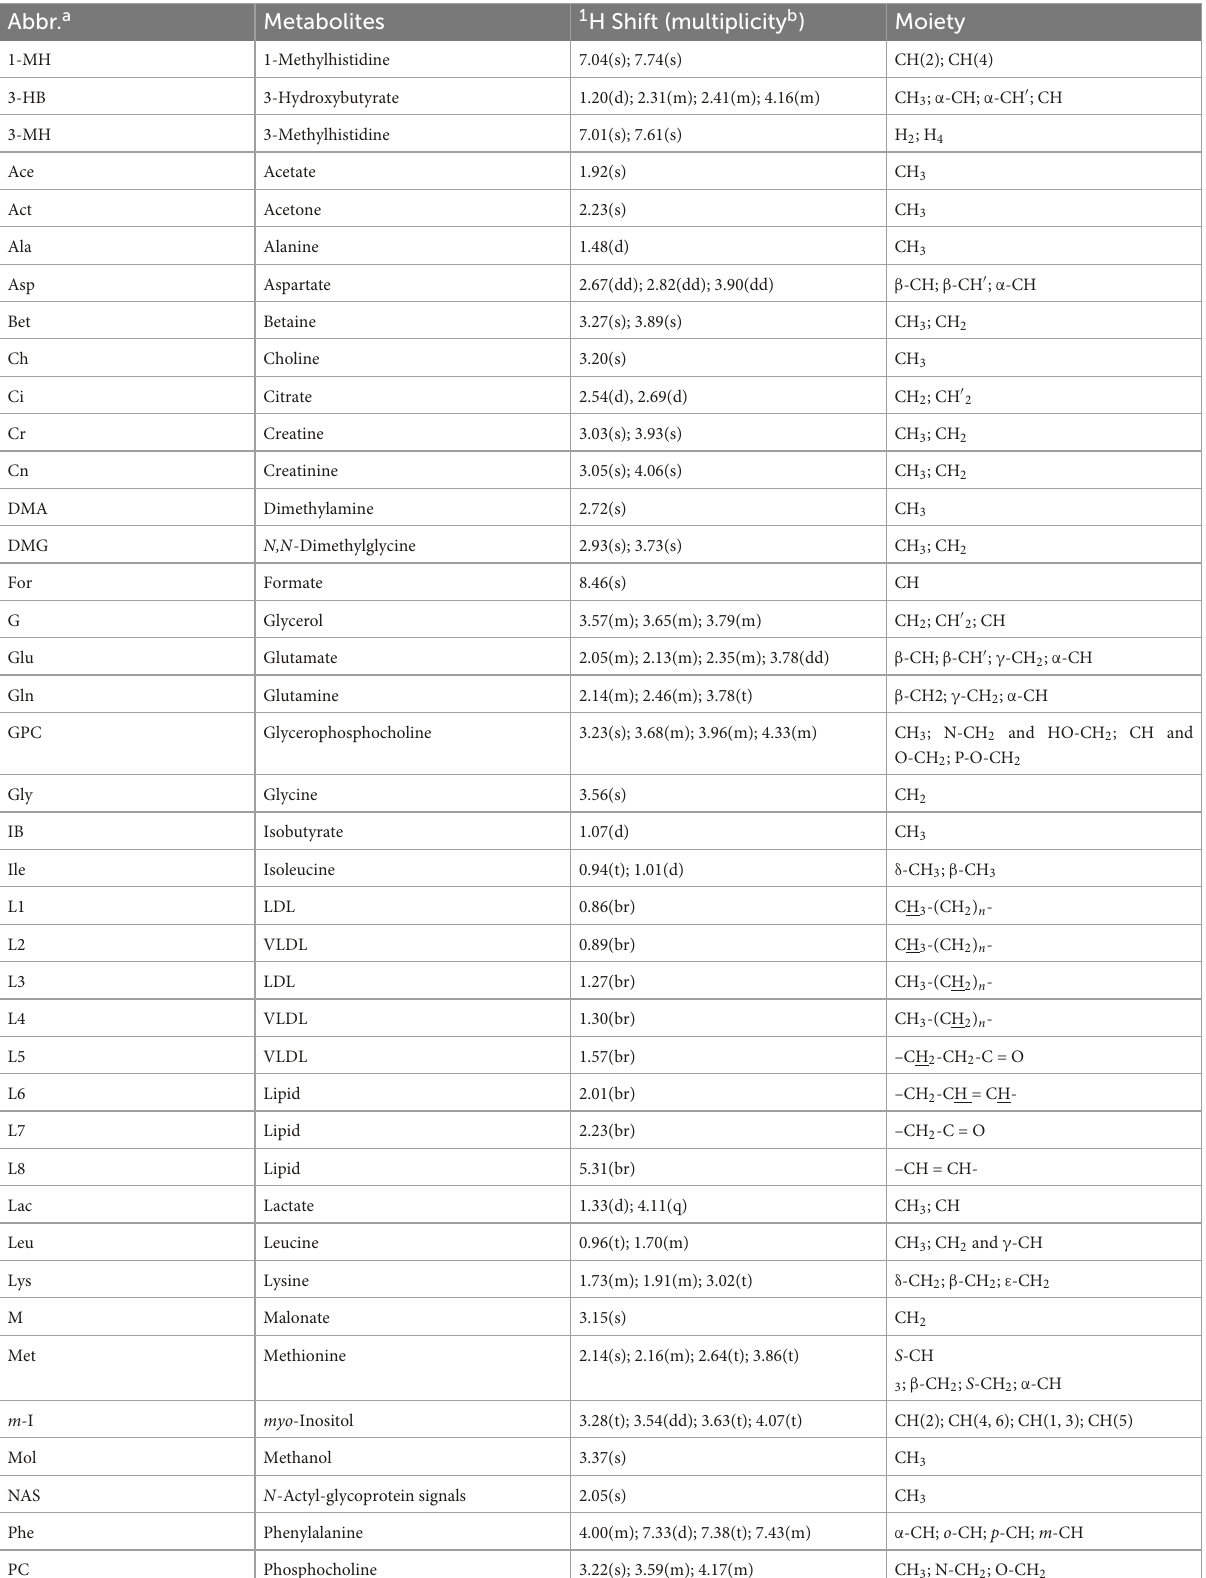
TABLE 2 Metabolite assignments of serum nuclear magnetic resonance (NMR) data. Abbr.